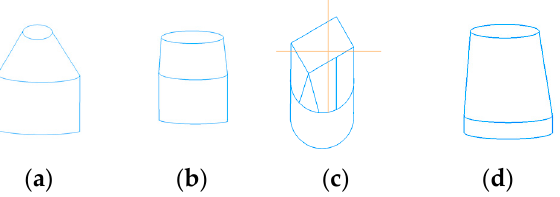
Figure 3. Drill bit inserts [9]: ( a ) radial bow, ( b ) crest geometry, ( c ) conical and rectangular shape, ( d ) double conical.